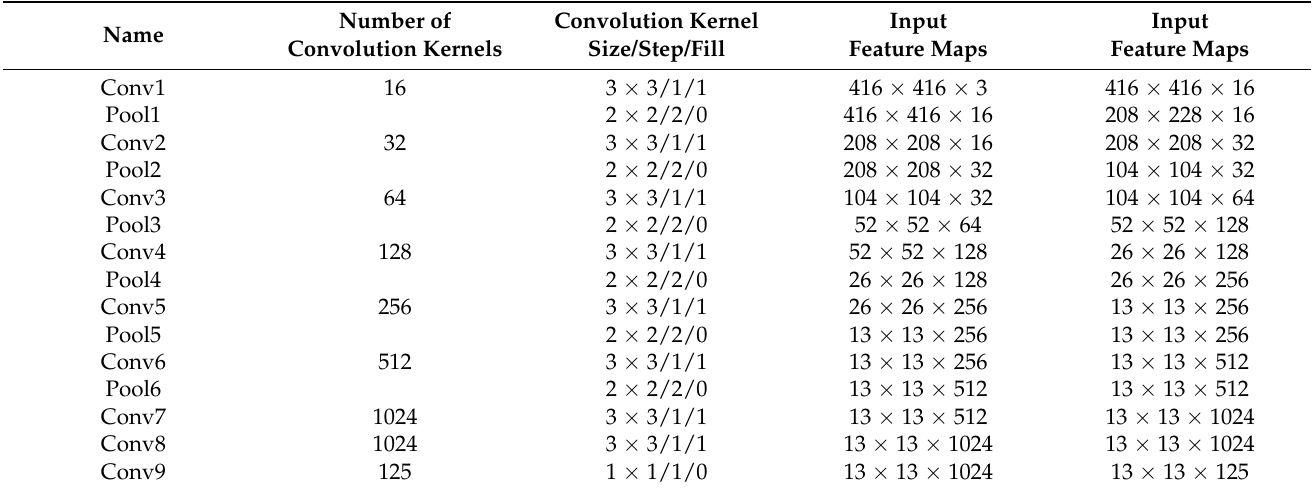
Table 1. The network structure of